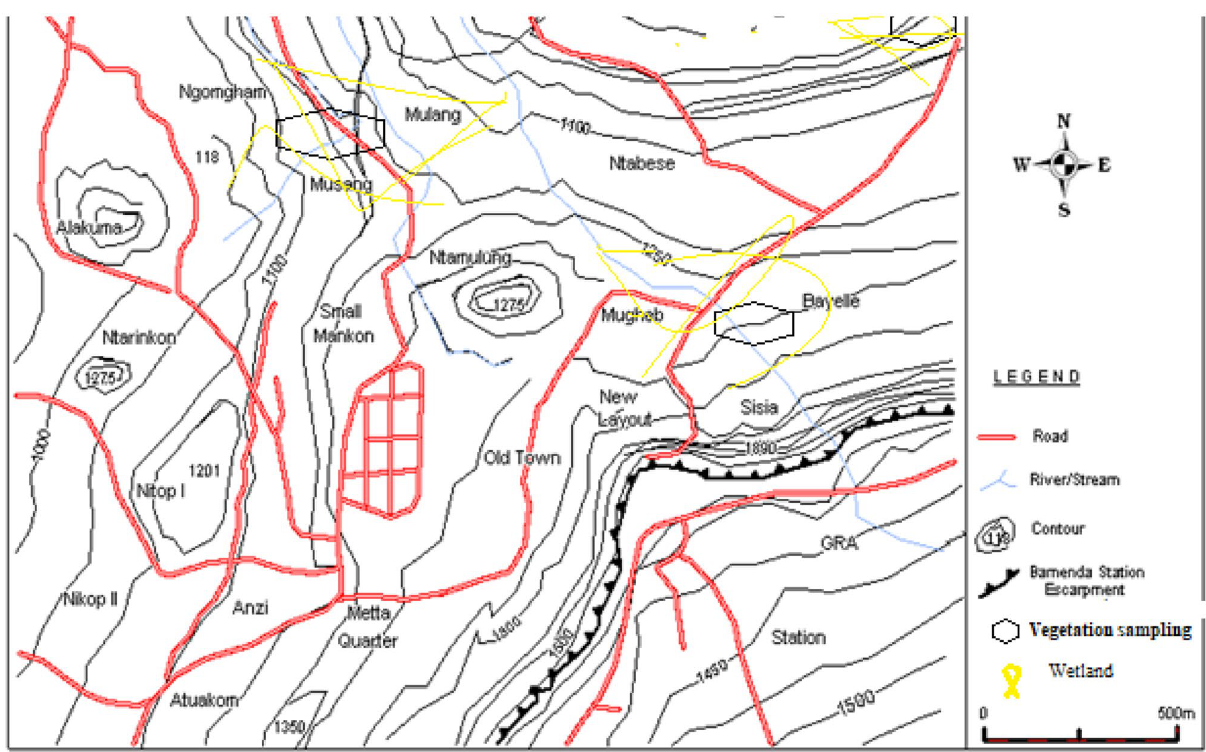
Figure 1. Relief Map of Bamenda showing the Bamenda escarpment, topography and the location for quadrat